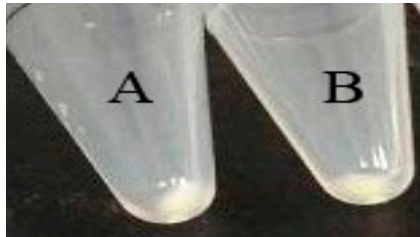
Figure 4. Effect of miR-21a on cell pellets. Melanocytes transfected with: miR-21a plasmid ( A ); and NC ( B ).